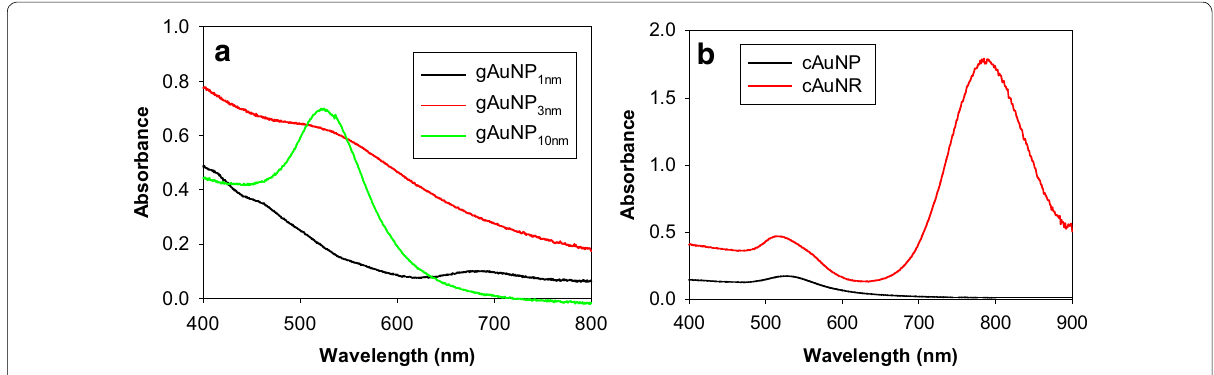
Fig. 1 UV‑vis spectra of a gAuNP with core sizes of ~ 1, 3, and 10 nm and b cAuNP and